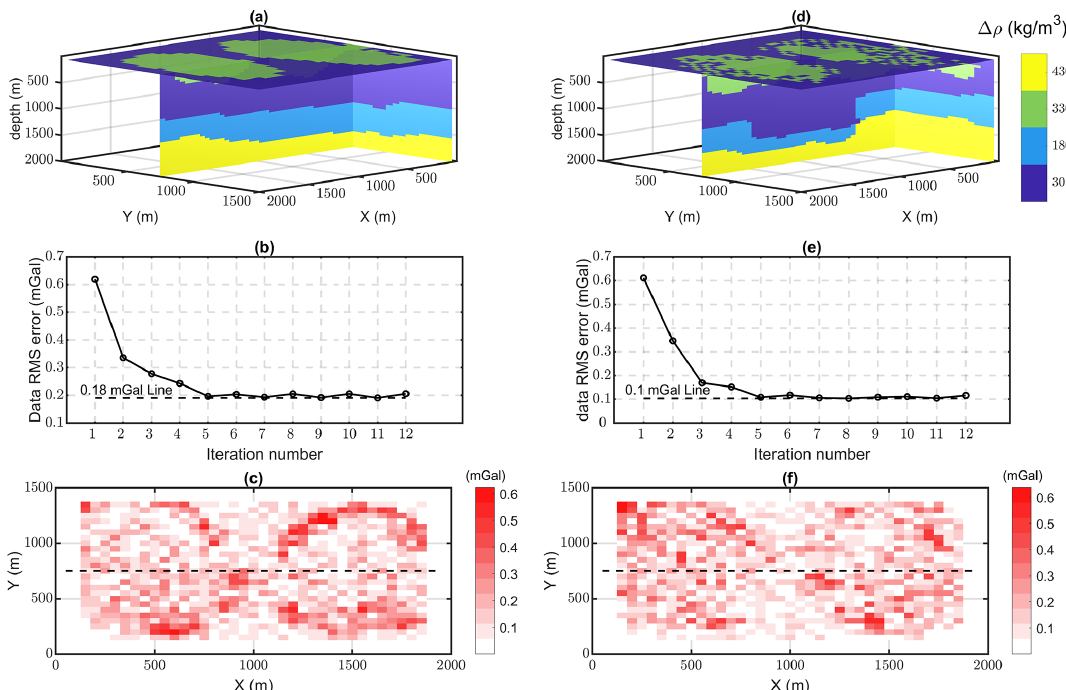
Figure 5. Final inverted models from the seismically constrained (a) and unconstrained inversion (d) , evolution of the data RMSE during constrained (b) and unconstrained inversion (e) , and the corresponding differences between the calculated data and synthetic observed data, respectively (c, f)